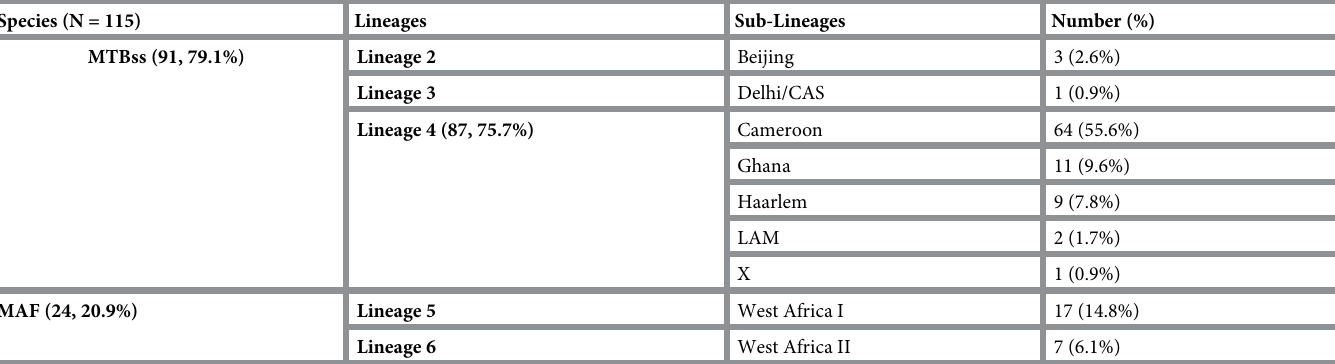
Table 2. Prevalence of Mycobacterium tuberculosis complex lineages and sub-lineages.